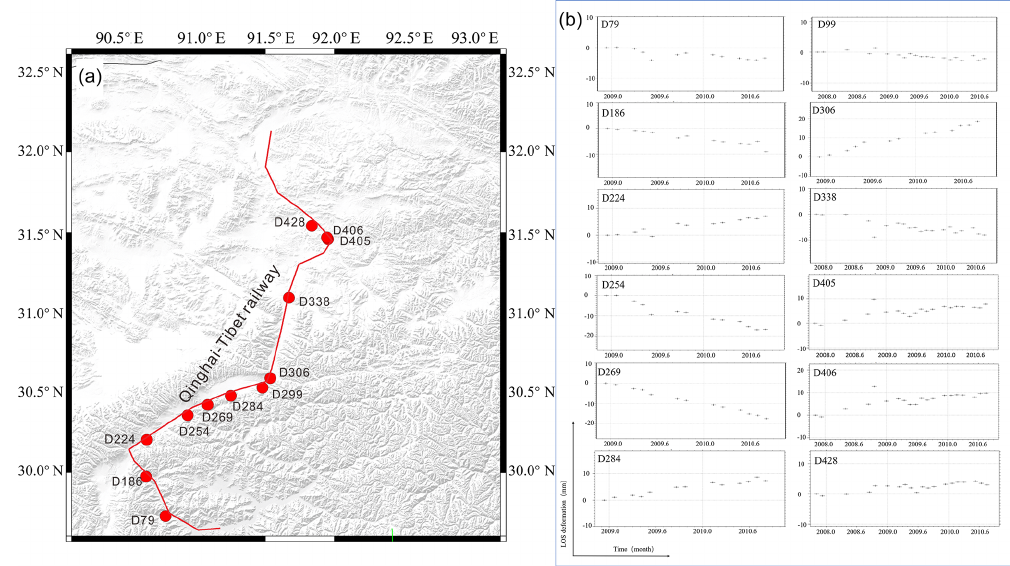
Figure 8. Deformation of a high-voltage power tower. (a) The location of the power tower. (b) The time series of the deformation character- istics of the power tower.